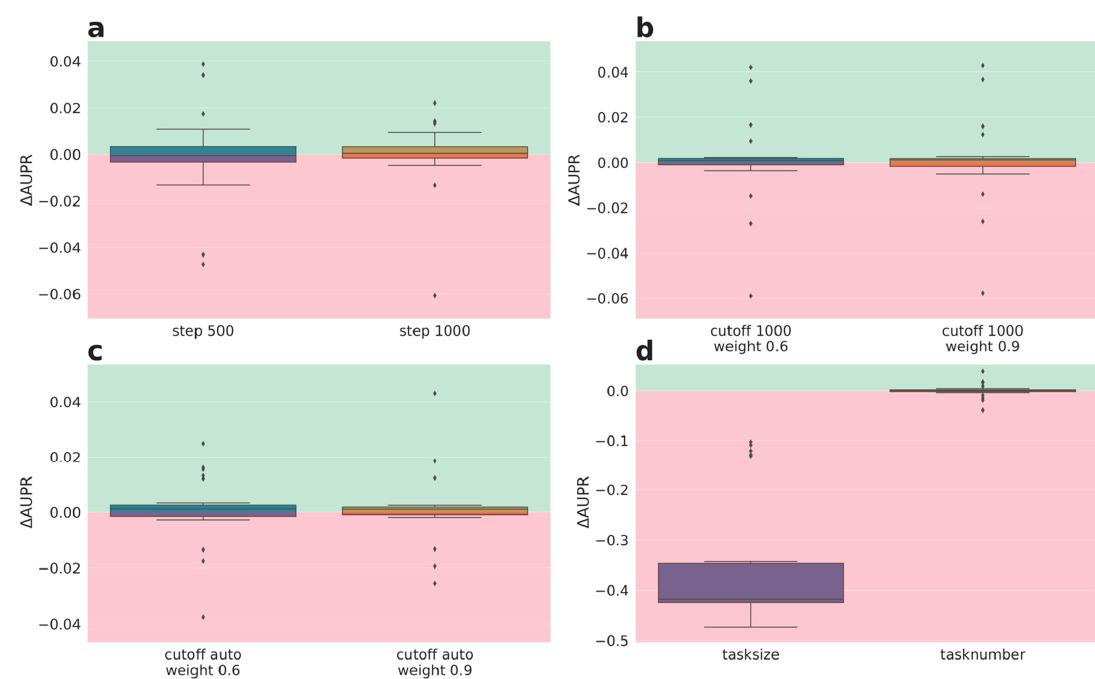
Figure 3. Phase II results of different weighting schemes averaged over 5 partners and 5 folds for lower quartile task (AUPR): ( a ) continuous weighting scheme with weight 0.02 and steps left: 1000 and right: 500, ( b ) fixed weighting scheme with cutoff 1000 and left: weight of 0.6 and right: weight of 0.9, ( c ) fixed weighting scheme with 95% quantile cutoff and left: weight 0.6 and right weight 0.9, ( d ) left: weighting based on task size, right: weight set to one divided by number of datapoints. Green: better performance than baseline (1), red: worse performance than baseline.